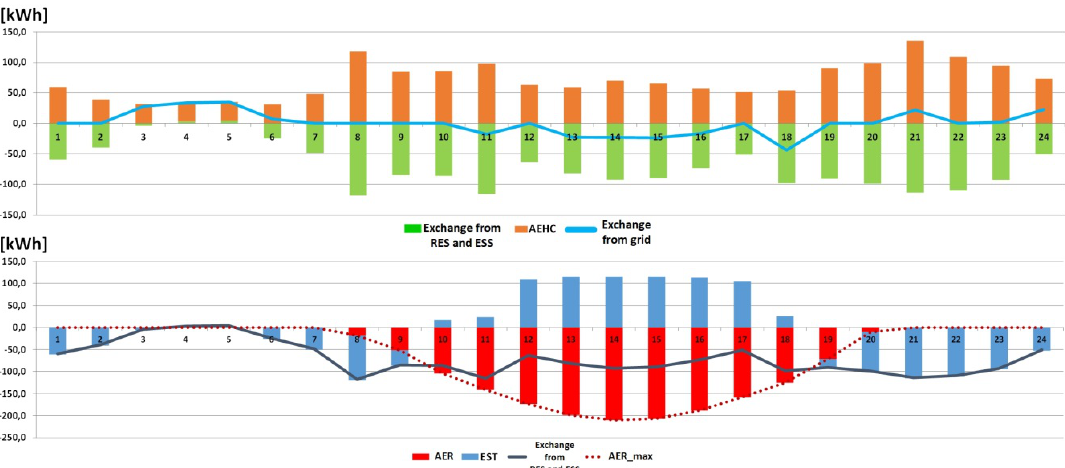
Figure 13. Energy management during the simulation day under the daily net metering scheme, with an ESS configuration.